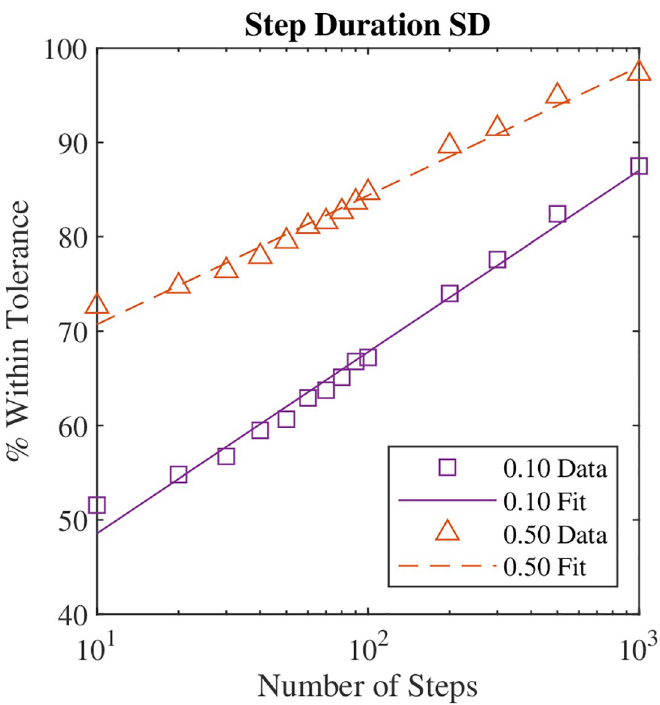
Fig 2. Brute force simulation accuracy vs. number of steps in the simulation. The percentage of simulations within 0.1 or 0.5 normalized units of the Markov chain metric values is shown. As the number of steps in the brute force simulation increases, more simulations match the Markov chain step duration standard deviation. The increase in accuracy as the number of steps in the brute force simulation increases is true for all gait parameters.